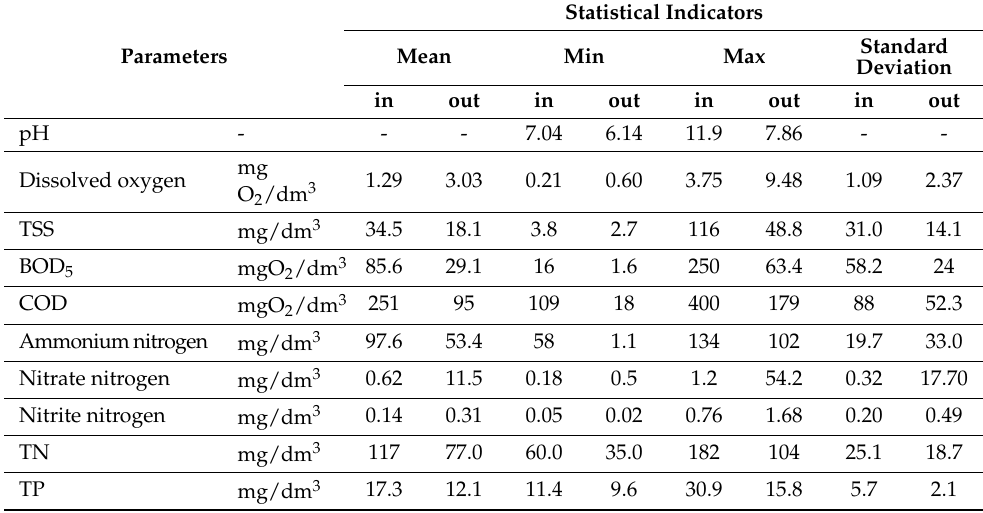
Table 3. Pollutants concentrations in the inflow and outflow of the facility no.